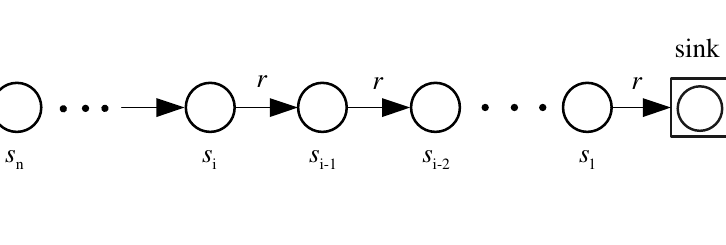
Figure 3. Linked sensor network.